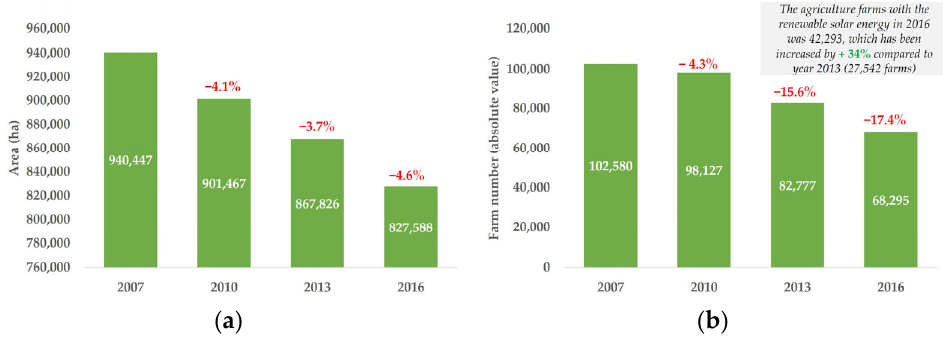
Figure 9. Farm areas and numbers in the Lazio region, based on ISTAT and the 2010 Agriculture Census. ( a ) Farm areas by hectare between 2007–2016, where the area lessened by 112,859 ha, and the figure indicates an annual decrease of 1.5%, approximately. ( b ) Farms number in the same period. The figure illustrates that between 2007 and 2010, the amount decreased by 4.3%, 15.6% between 2010 and 2013, and 17.4% between 2013 and 2016. In line with the study context, the number of agricultural farms with solar renewable energy increased by 34% between 2013 and 2016.